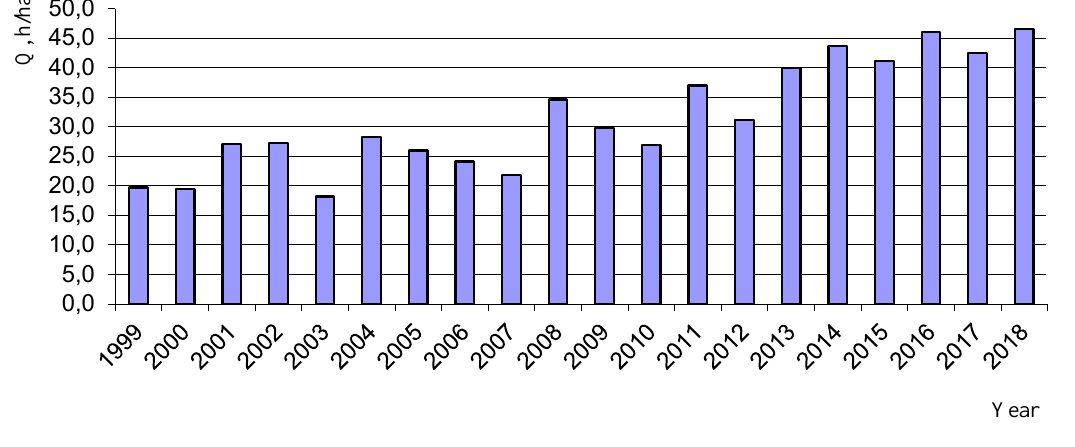
Source : The State Statistics Service of Ukraine (2018).